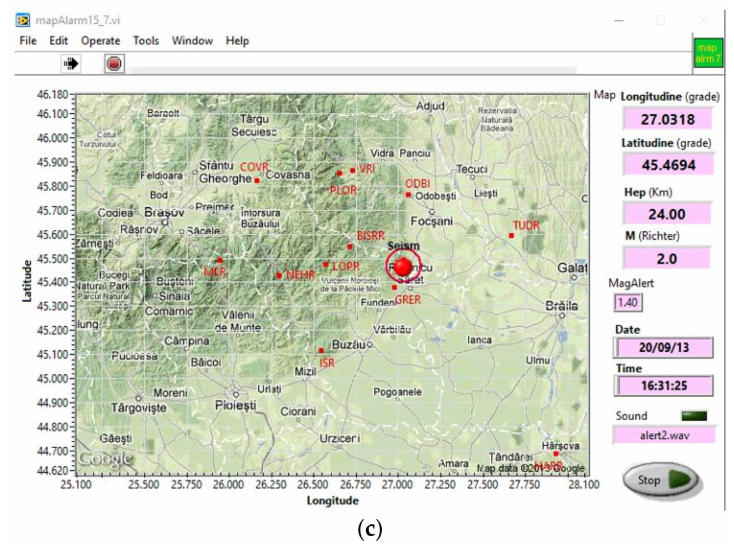
Figure 17. EEW (Earthquake Early Warning) info alert network: ( a ) server of messages; ( b ) mes- sages receiver which provides information and operates protection elements (gas blocking solenoid valve, for example); ( c ) displays the earthquake parameters. The traffic light symbol from Figure 17b has 5 states: green—no warning elements; green–yellow—attention; yellow—warning; yellow–red—alert and red—major alert.